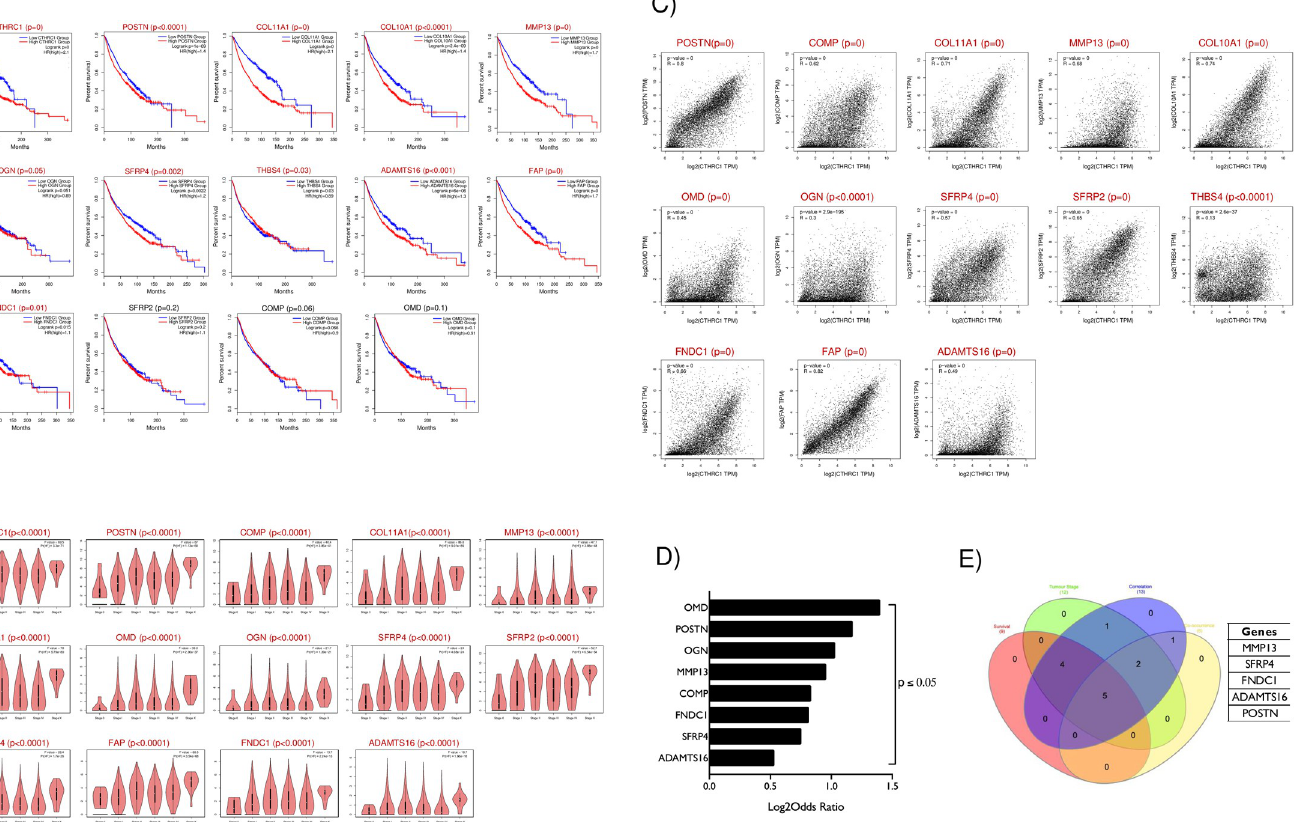
Fig 5. Validation of CTHRC1 and its hub genes in cancers. A) Graph represents percentage survival in 30 cancers with “high” (RED plot) vs “low” (BLUE plot) expression for CTHRC1 or each of its 13 hub genes (POSTN, COMP, COL11A1, MMP13, COL10A1, OMD, OGN, SFRP4, SFRP2, THBS2, FAP, FNDC1 and ADAMTS16) using GEPIA2 database. The significance of the difference in survival is listed above each graph. p values are as indicated above the graph. Genes with significance (p � 0.05) are listed in RED and those lacking significance in BLACK. p values = 0 are representative of very high significance. B) Violin plot shows the expression of CTHRC1 and each of its 13 hub genes across pathological stages in 30 cancers analyzed using the GEPIA2 database. Differences across the stages of cancer for each gene of interest was calculated using the ANOVA test and significance was reported. p values are as indicated above the graph. Genes with significance (p � 0.05) are listed in RED. C) Scatter plots show the Spearman correlation analysis for CTHRC1 and its 13 hub genes in 30 cancers using GEPIA2. p values are as indicated above the graph. Genes with significance (p � 0.05 or p = 0) are listed in RED. D) Bar graph shows log2 odds ratio from the cBioPortal for statistically significant co-occurrence between CTHRC1 and hub genes of interest (8 genes) in 30 cancer types. E) This Venn diagram shows the overlap of genes that significantly affects survival and tumour staging and are related in correlation and co-occurrence analysis in 30 cancer types. The table lists the 5 overlapping genes detected in this